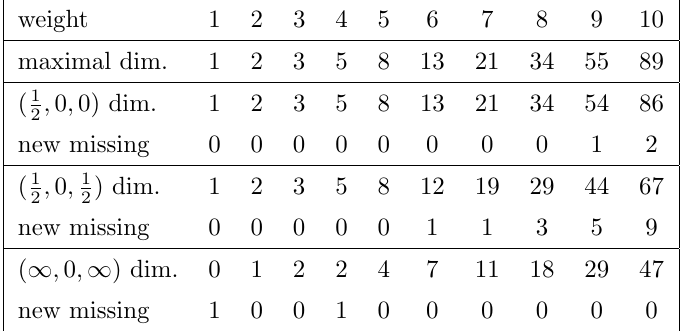
Table 19 . Dimensions of H hex when restricted to various alternating-sum points, for weights up to 10. The maximal dimension corresponds to all alternating sums and is given by the Fibonacci sequence. It is attained through weight 10 by the points ( 1 ( 1 ; 0 ; 1). The ‘new missing’ lines refer to the number of values that are absent at a given weight 2 that are not predicted to be absent by the coaction